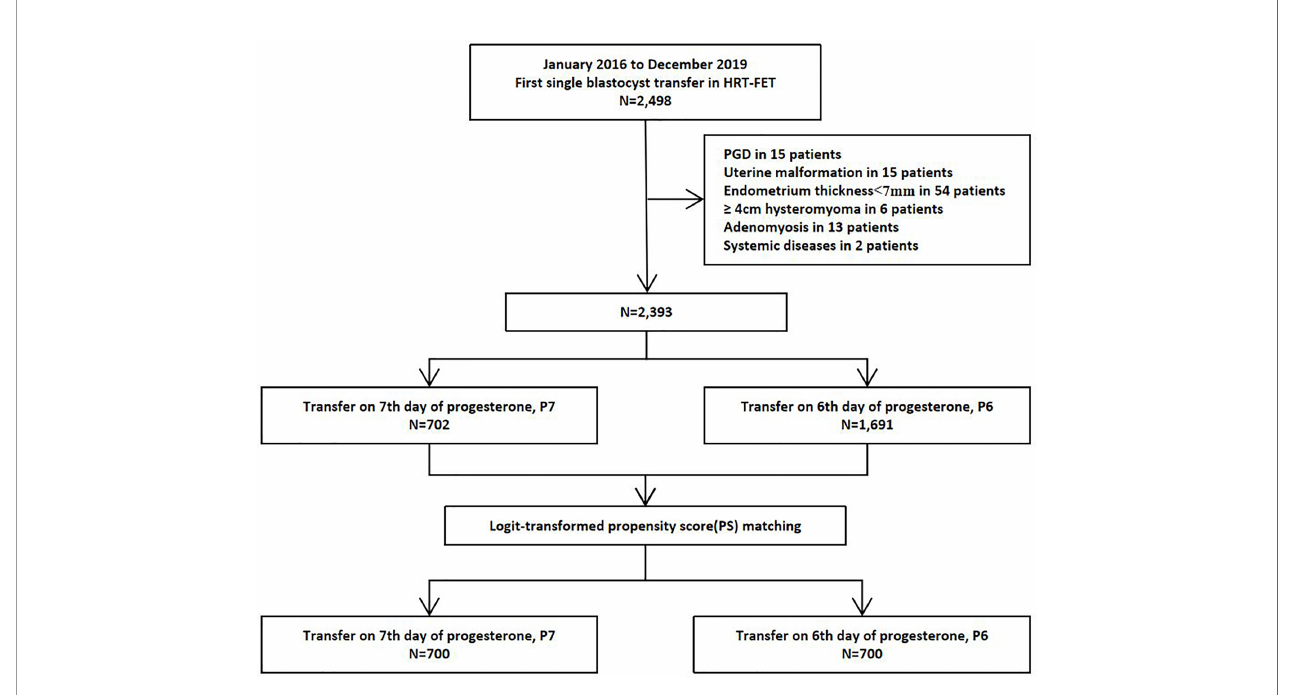
FIGURE 1 | Study fl ow